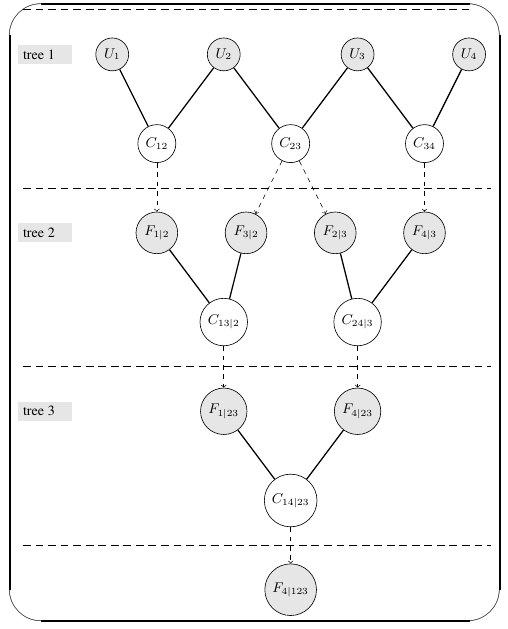
Figure 2. Hierarchical nesting of bivariate copulas in the construc- tion of a 4-dimensional vine copula through conditional